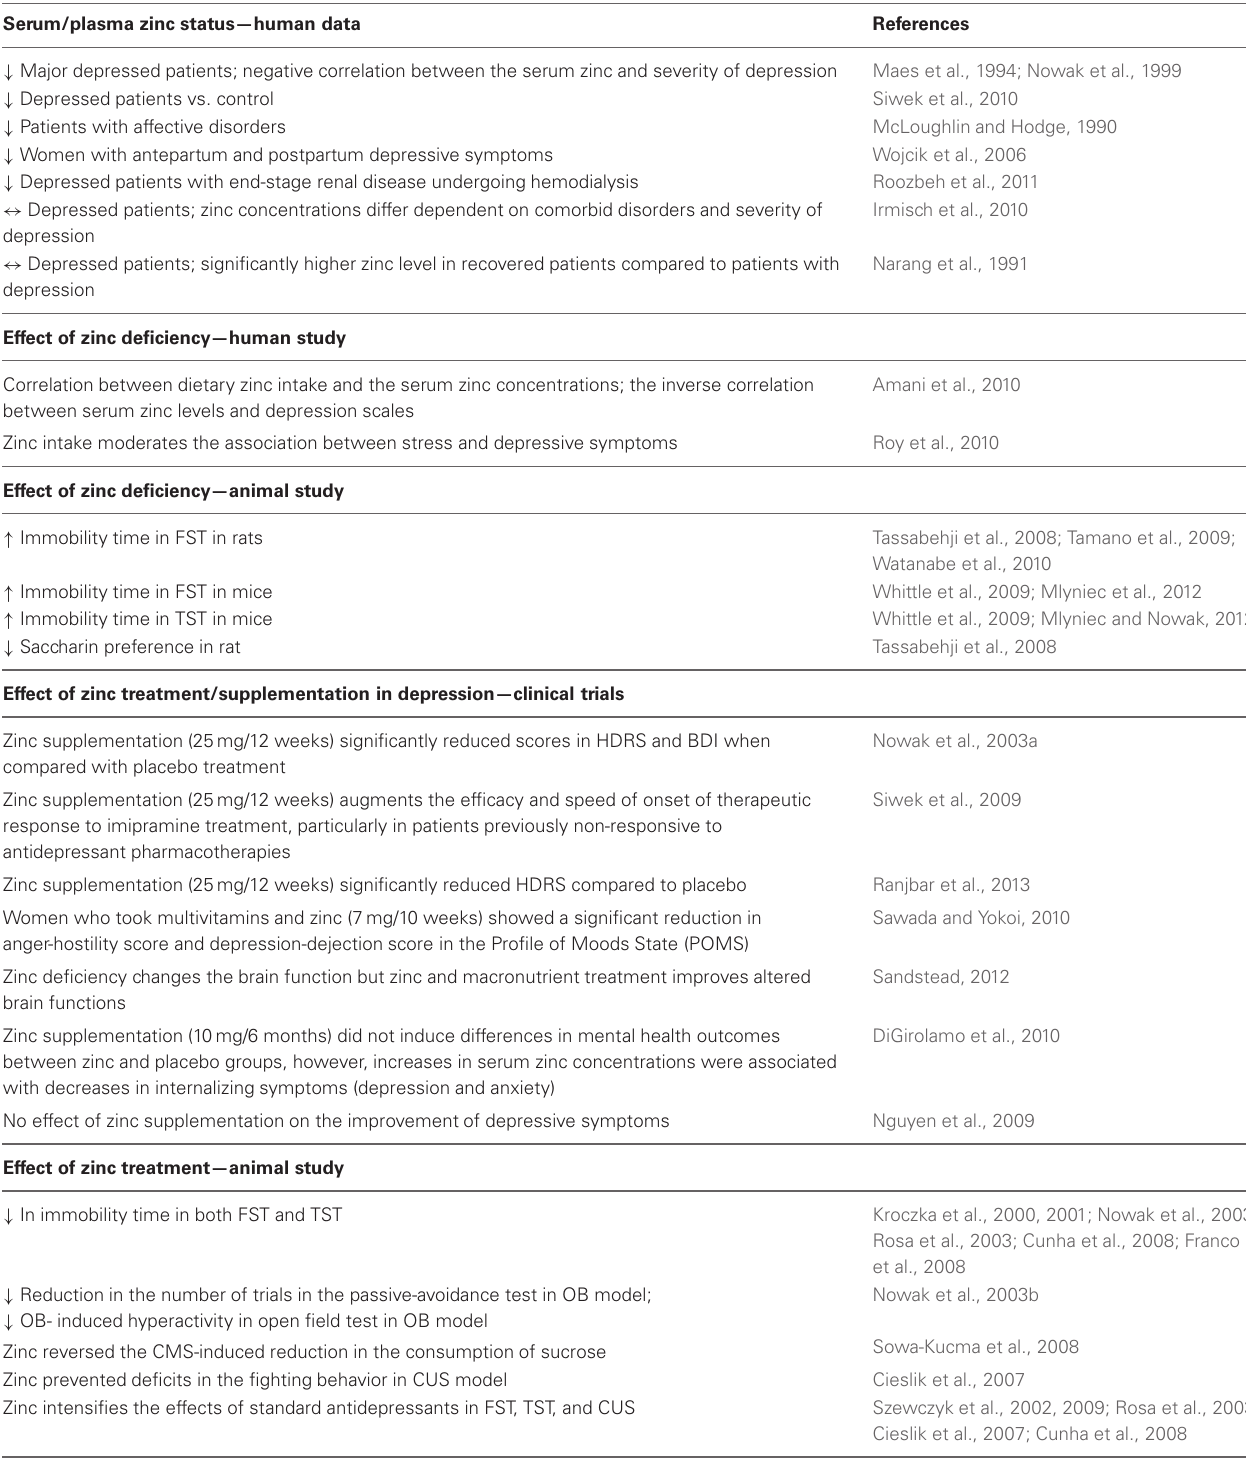
Table 1 | Summary of the main clinical and preclinical findings supporting the involvement of zinc in